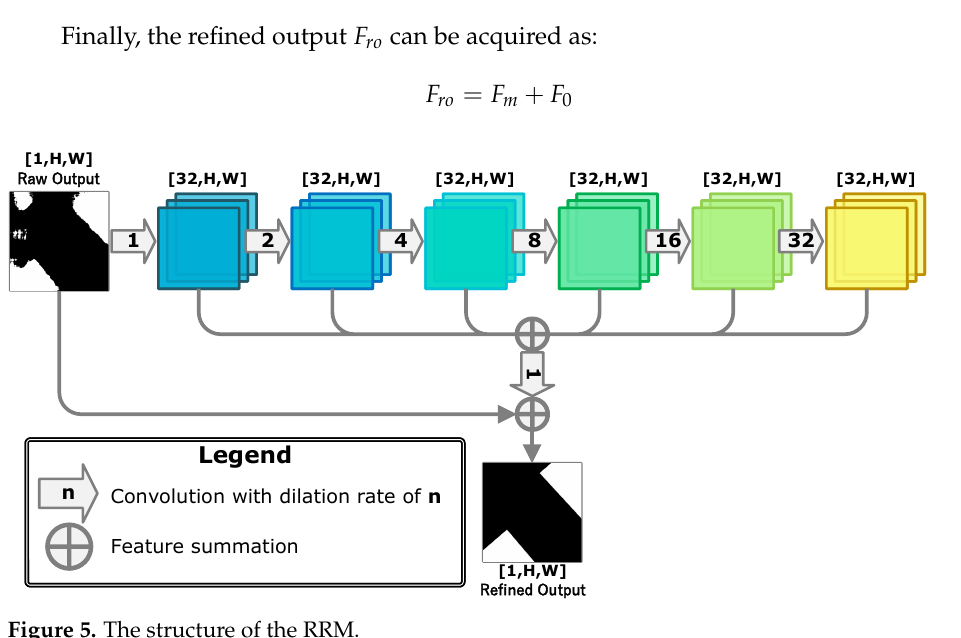
Figure 5. The structure of the